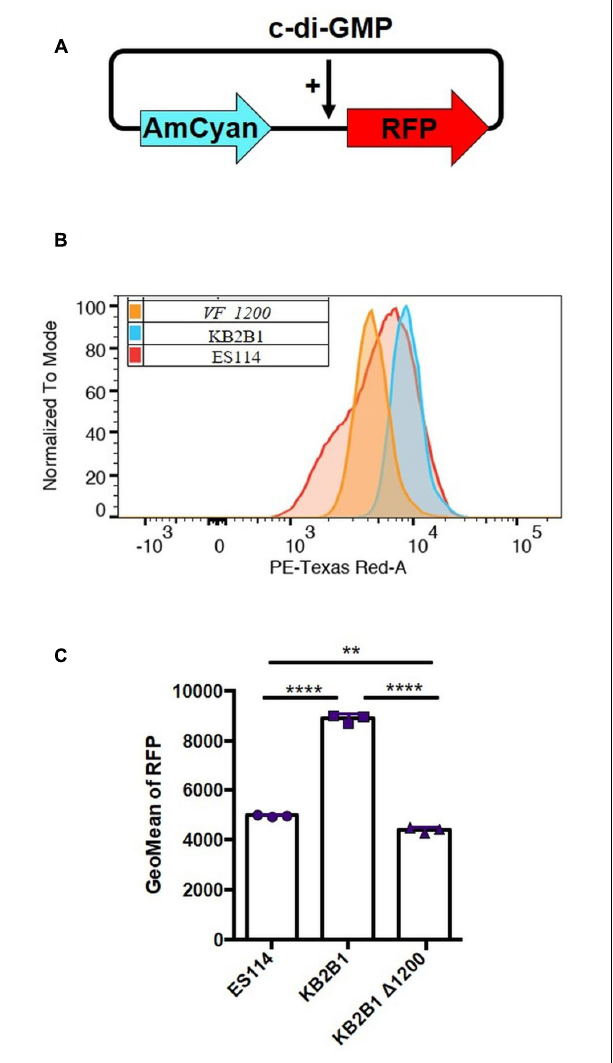
FIGURE 8 | Comparisons of c-di-GMP levels. (A) Diagram of biosensor plasmid pFY4535 in which expression of the gene for red fluorescent protein (RFP) is controlled by a c-di-GMP riboswitch, while expression of the gene for AmCyan is independent of c-di-GMP levels. (B,C) Quantification of RFP relative to AmCyan following growth of pFY4535-containing KB2B1, KB2B1 (cid:49) VF_1200 (KV8973), and ES114 strains, as normalized to mode (B) and Geometric Mean (GeoMean) of RFP (C) . Statistics were performed using one-way ANOVA. ** p = 0.0029; **** p < 0.0001. double mutants. A Double (cid:49) VF_1200 litR mutant